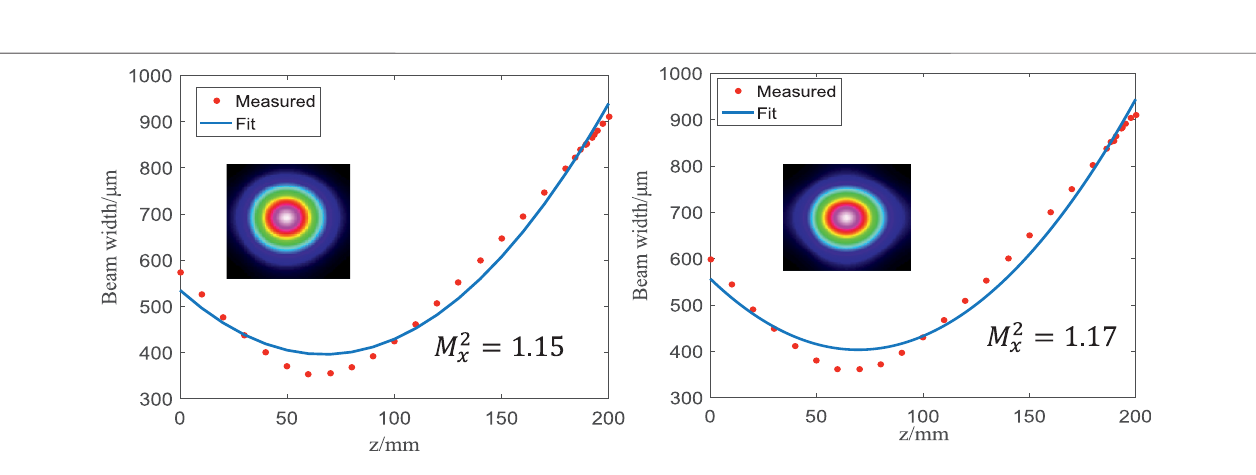
FIGURE 14 | The schematic diagram of the experiments and experimental setup for grating thermal deformation.